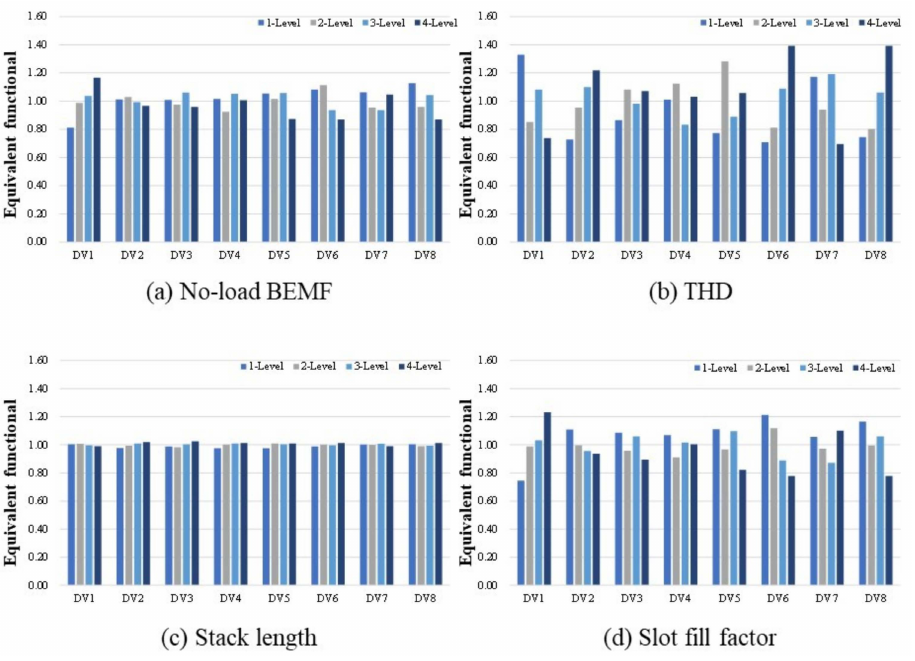
Figure 17. Effect analysis results (24P